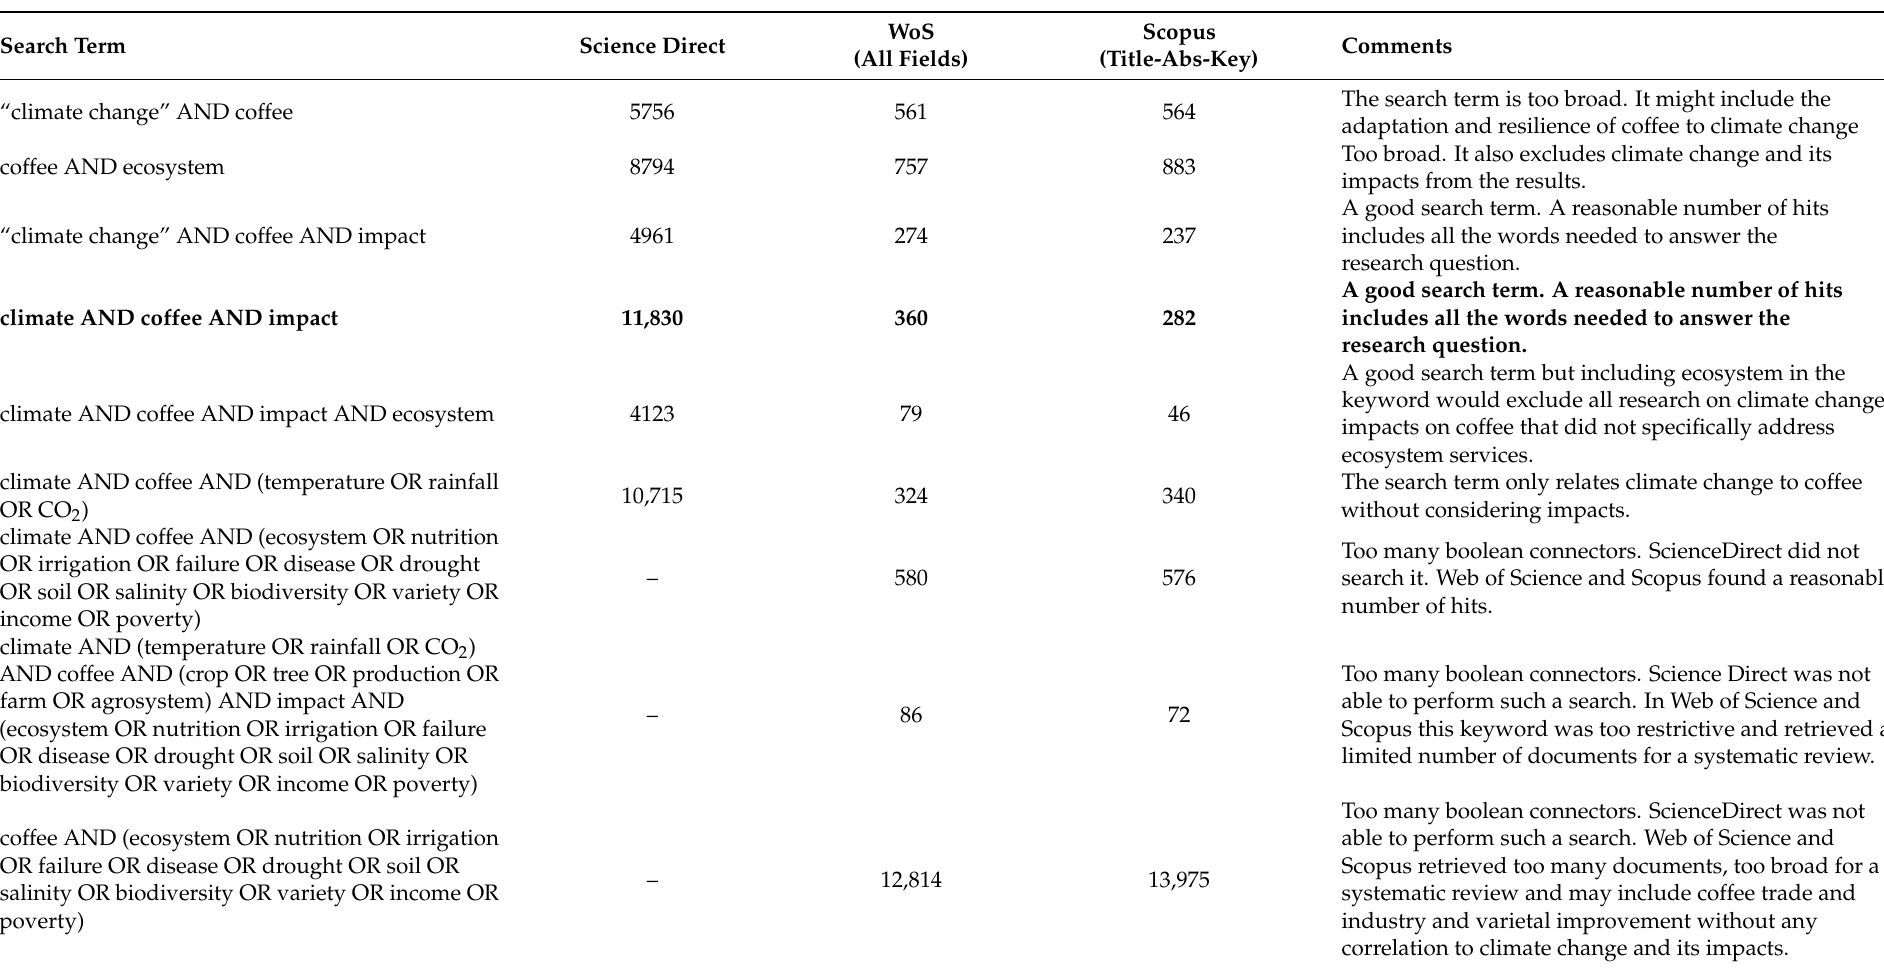
Table 3. Development, trial, refinement, and screening of search terms. The number of papers reached per search term are included. The search term stressed in bold represents the ideal